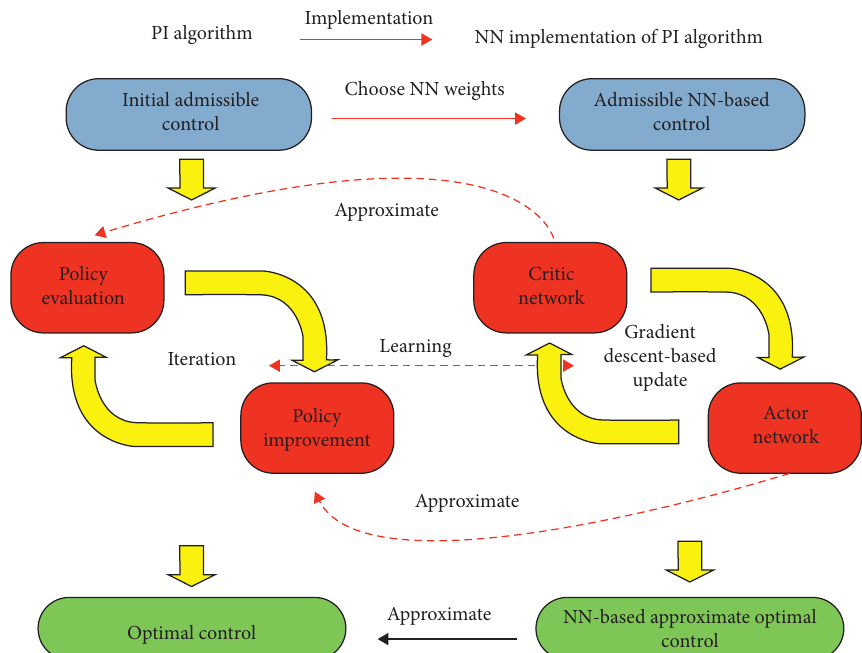
Figure 2: NN implementation diagram of PI